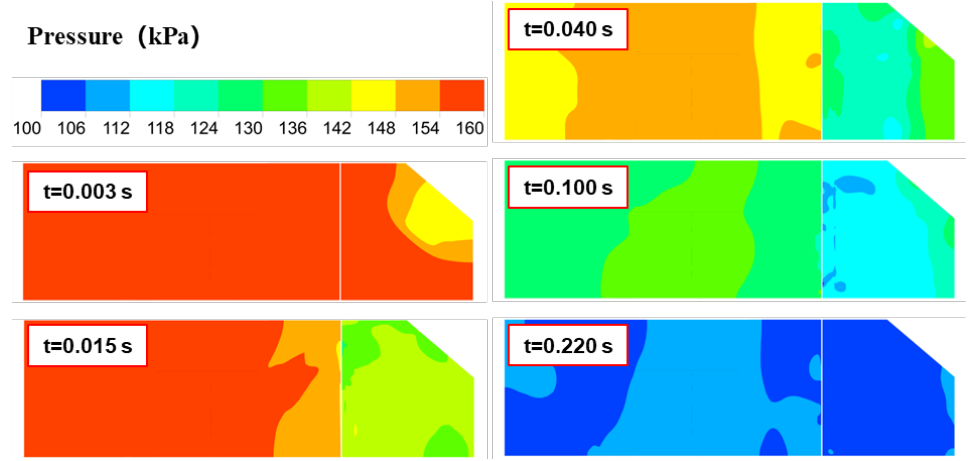
Figure 12. Pressure distribution in the middle section at 6 characteristic moments, predicted by 3-D CFD simulation.